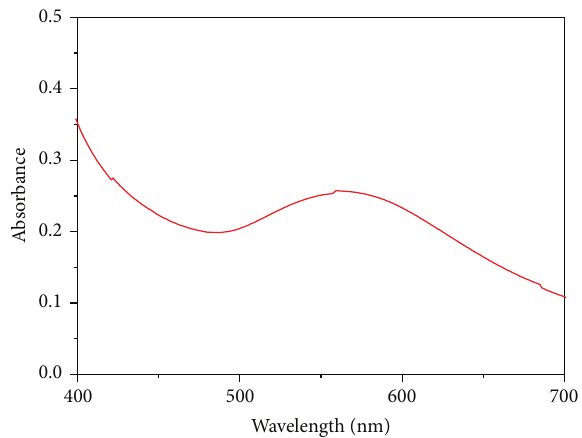
Figure 1: UV-Vis spectrum of copper nanobuds dispersed in deionized water at room temperature exhibiting a peak at 573 nm.